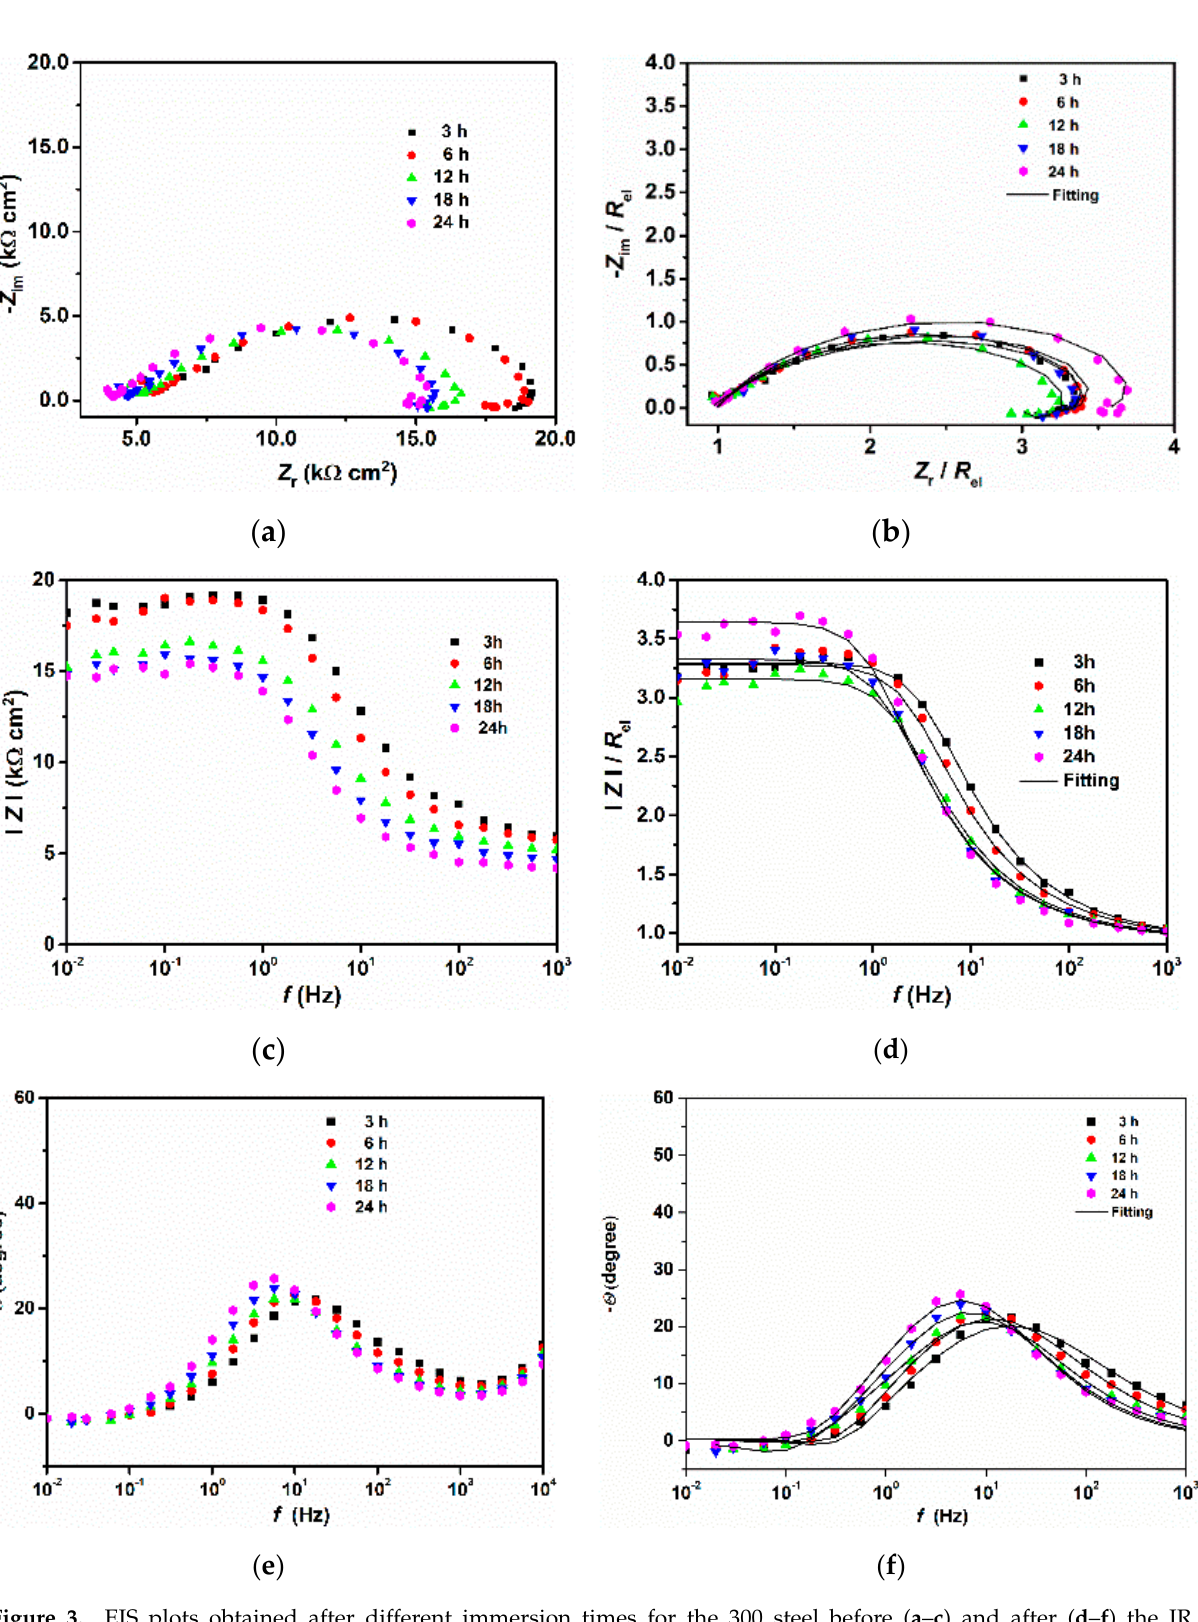
Figure 3. EIS plots obtained after different immersion times for the 300 steel before ( a – c ) and after ( d – f ) the IR drop correction.